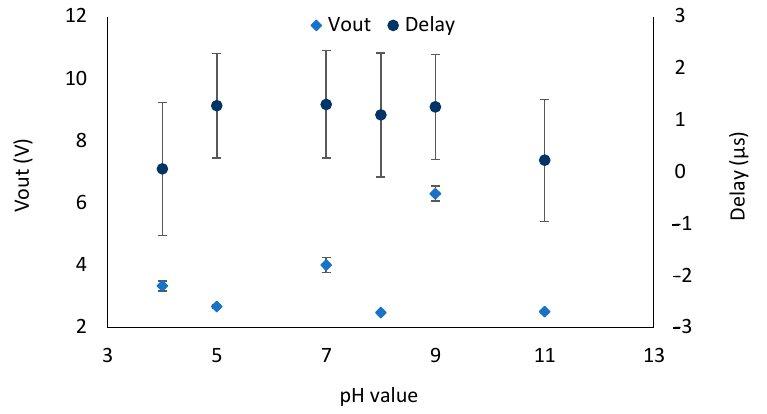
Figure 12. Delay and Vpp for frequency equal to 242 kHz for the different pH values.